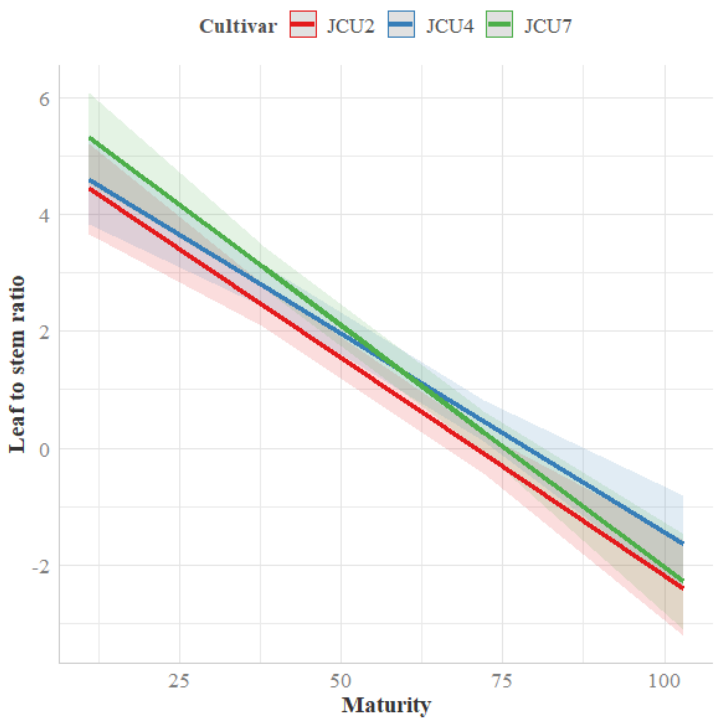
Figure 2. Effect plots for the interactions between cultivar and maturity on desmanthus leaf to stem mass ratio ( p = 0.04). Table 2. Mean leaf to stem mass ratio (L/S), dry matter (DM; %) and chemical composition (% DM) of desmanthus harvested at varying maturity stages.